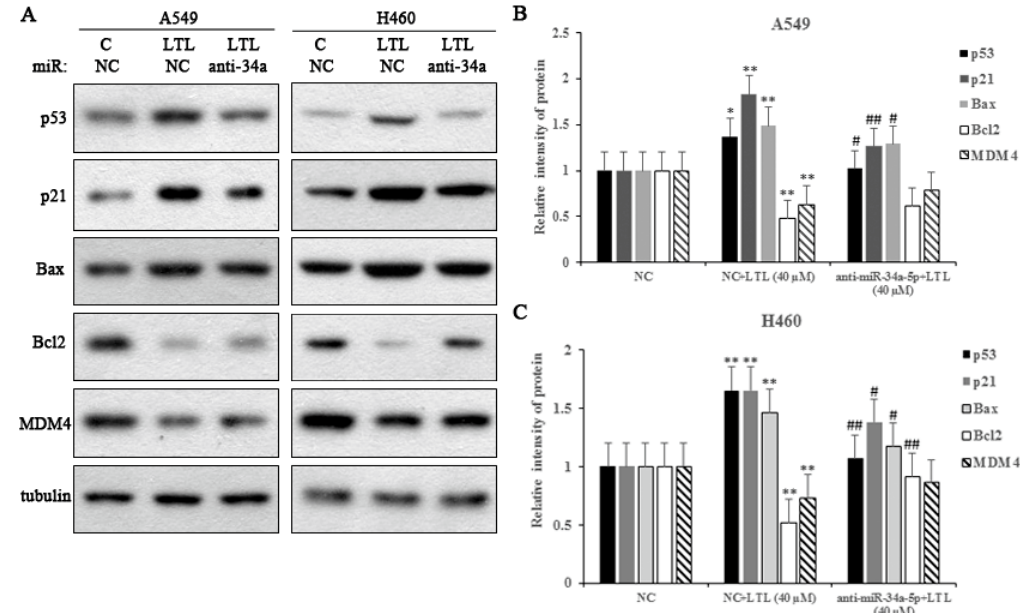
Figure 9. Effect of miR-34a-5p inhibition on apoptosis-related protein expressions in vitro. ( A ) Protein expression levels of p53, p21, Bax, Bcl-2, and MDM4 in A549 and H460 cells treated with anti-34a (LV-hsa-miR-34a-5p-inhibition) or NC (negative control) after LTL (40 µ M) treatment for 24 h. Tubulin was used as an internal control; ( B , C ) Histograms represent quantification of the relative expression of the proteins. The results are expressed as means ± SD of three independent experiments. * p < 0.05, ** p < 0.01, compared with NC group; # p < 0.05, ## p < 0.01, compared with NC + LTL (40 μ M) group. C: control.